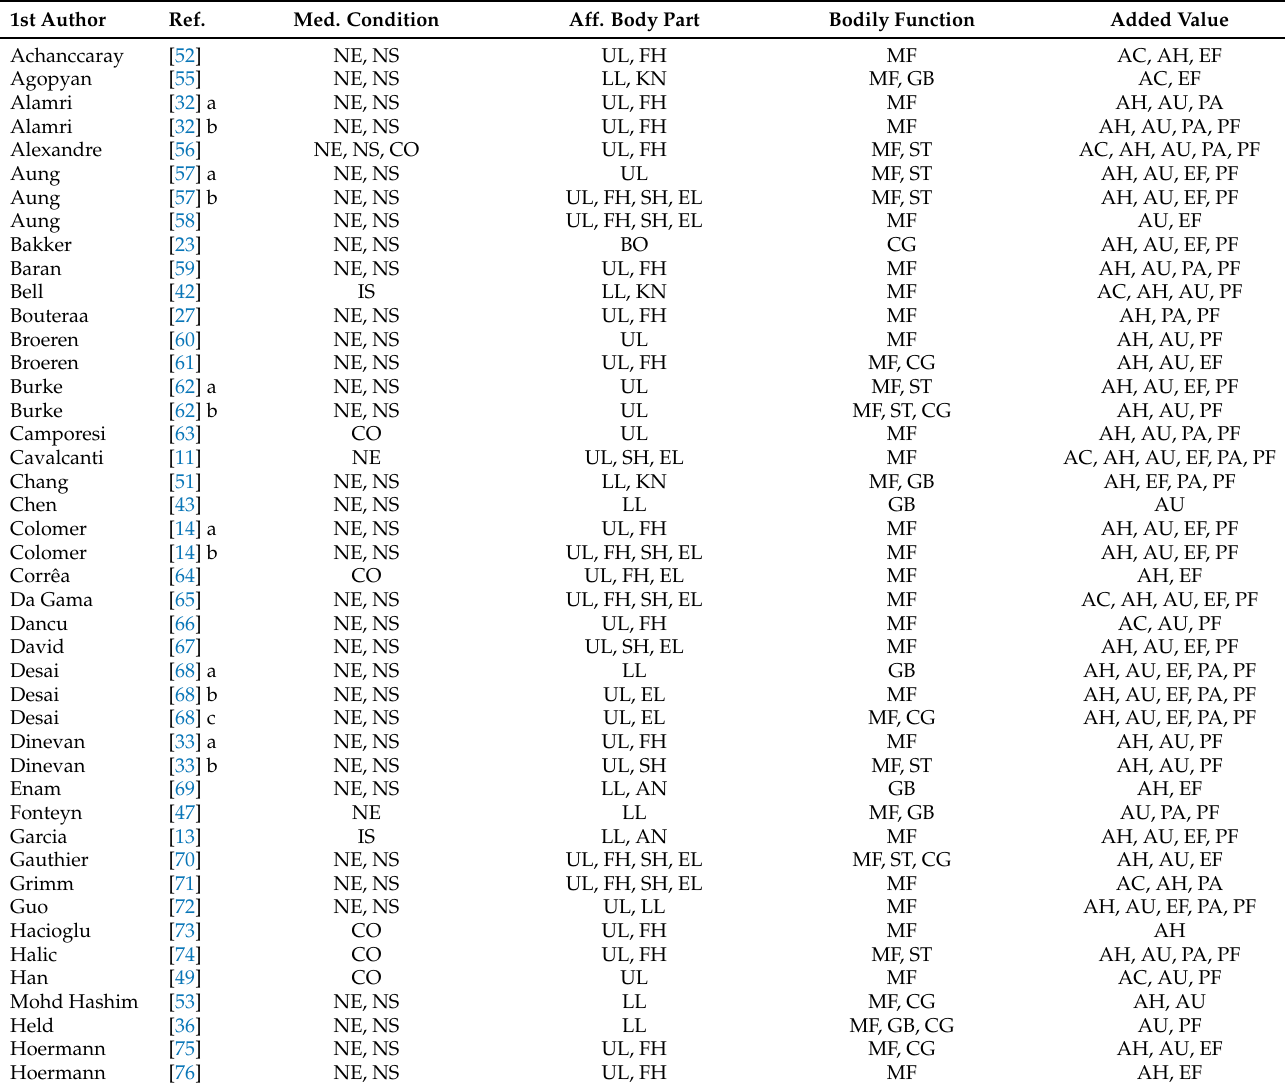
Table A1. Overview of the selected references—author names A–H, part 1/2, Abbr. in Table A7. Distinct applications within a reference are marked with lowercase